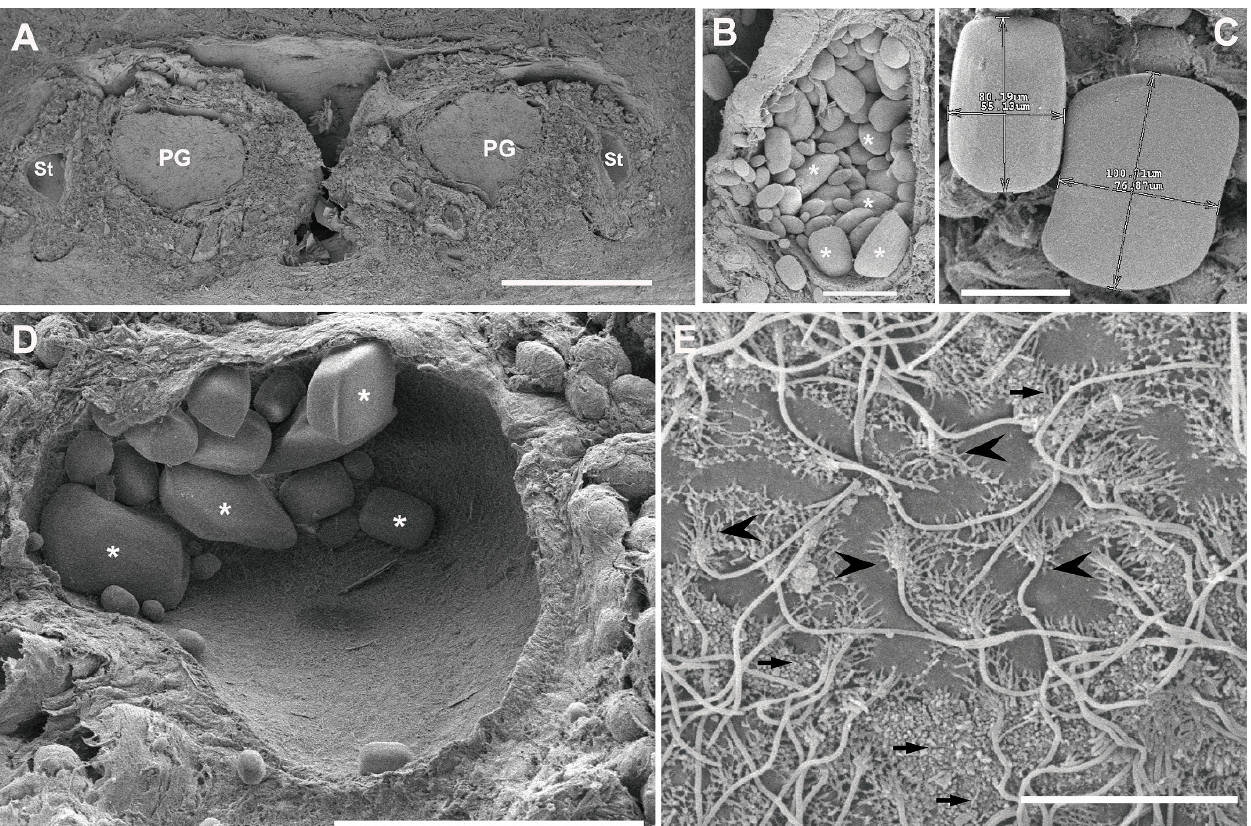
Figure 5. SEM. Internal morphology of P. maculata statocyst . Control animal. ( A ): Dorso-ventral cutting of the body anterior portion showing the statocyst location in the snail foot and linked ventrolaterally to each pleural ganglion (PG: pleural ganglion, St: statocyst). ( B ): Opened statocyst completely filled with statoconia (asterisk). ( C ): Differently sized statoconia. ( D ): Internal cavity of the statocyst covered by the sensory epithelium. Some of the aragonite crystals are visible (asterisk). ( E ): Inner statocyst sensory epithelia. Arrowheads point to the hair cells exhibiting their lonely kinocilia surrounded by a crown of stereocilia. Between them microvilli of the supporting cells are visible (arrows). Scale bar: ( A ) = 1 mm. ( D ) = 200 μ m. ( B ) = 100 μ m. ( C ) = 50 μ m. ( E ) = 5 μ m.